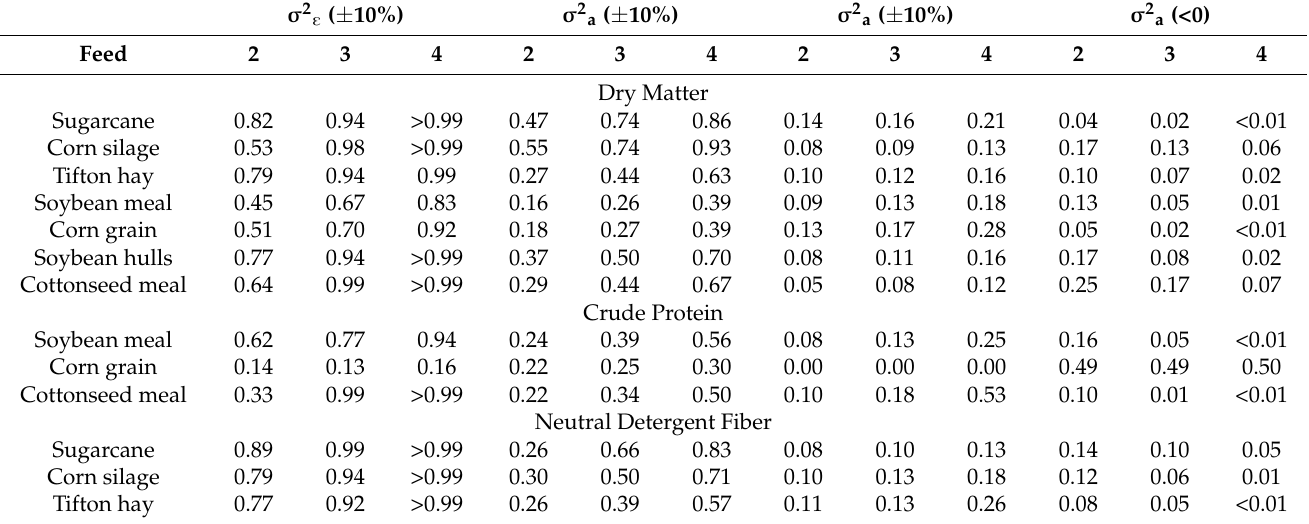
Table 4. Probabilities to obtain estimates of degradation rate [k/ λ ( ± 10%)], error variance [ σ 2 E ( ± 10%)], and variance among animals on degradation rate [ σ 2 a ( ± 10%)] lower or higher than 10% in relation to those obtained using five animals, and probabilities to obtain negative estimates of variance among animals on degradation rate according to the number of animals used in the in situ